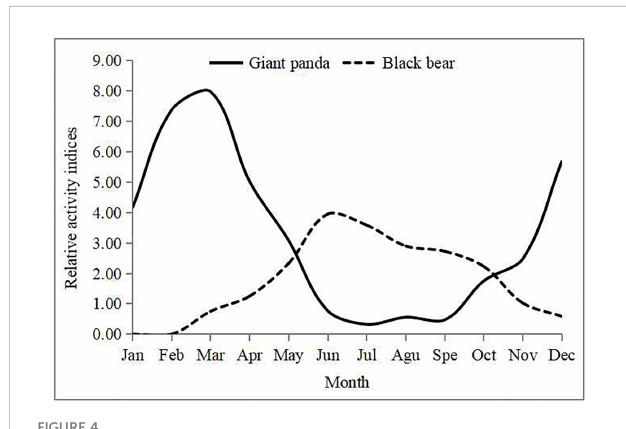
FIGURE 4 Relative activity indices (RAI) of giant pandas and Asiatic black bears for each month in Changing National Nature Reserve.